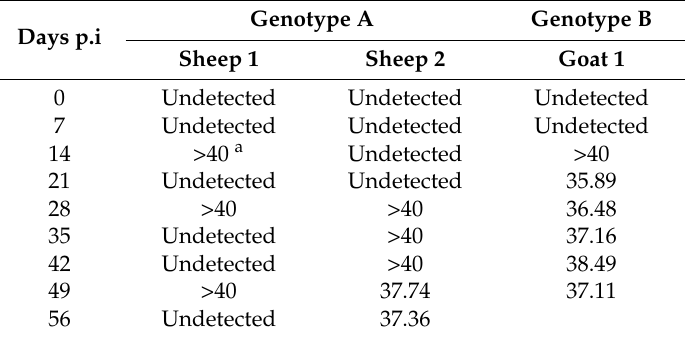
Table 6. Ct values obtained in leucocyte pellets over time after an experimental inoculation of two sheep with a genotype A strain and one goat with a genotype B strain.